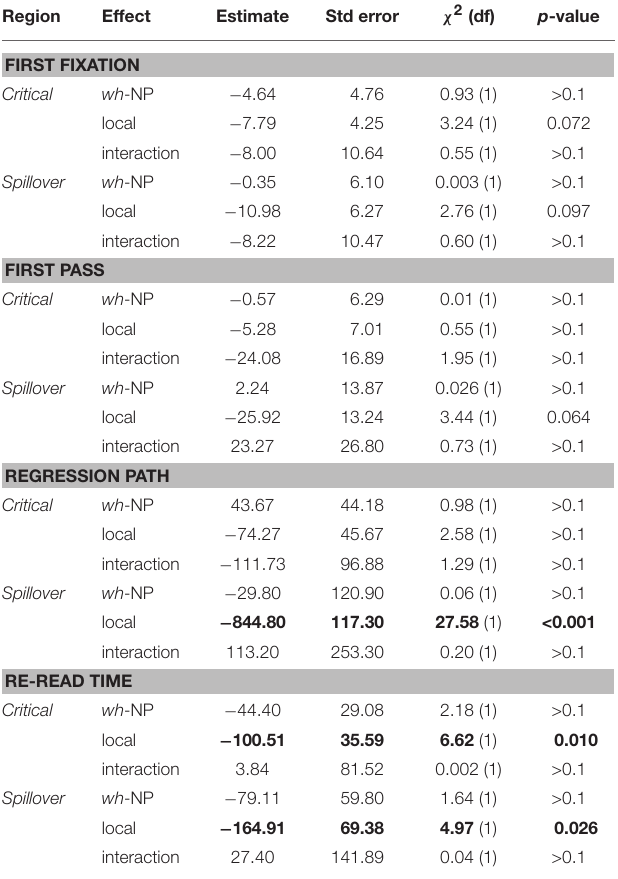
TABLE 6 | Combined ANOVA and LME results for Experiment 3. Region